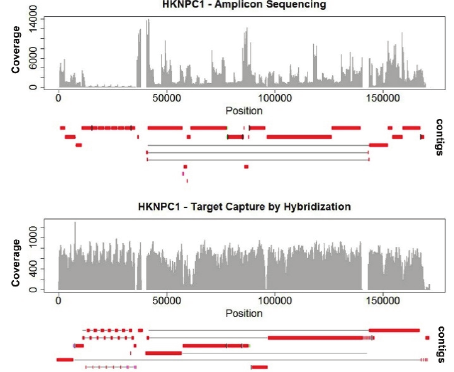
Figure 1. Coverage and alignment of contigs of HKNPC1 EBV by amplicon sequencing and target capture. Uneven read coverage is observed in amplicon sequencing of HKNPC1. More uniform coverage is observed in HKNPC1 enriched by target capture through hybridization using Agilent RNA-bait. The contigs assembled in amplicon sequencing are more fragmented than that from target capture.